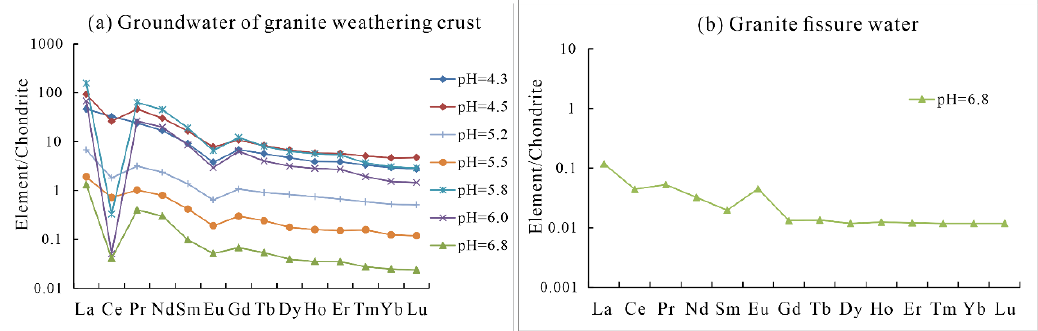
Figure 10. Chondrite - normalized patterns of dissolved REEs in the natural water of south China: ( a ) Groundwater of granite weathering crust, ( b ) Granite fissure water (date referenced from [50]) .